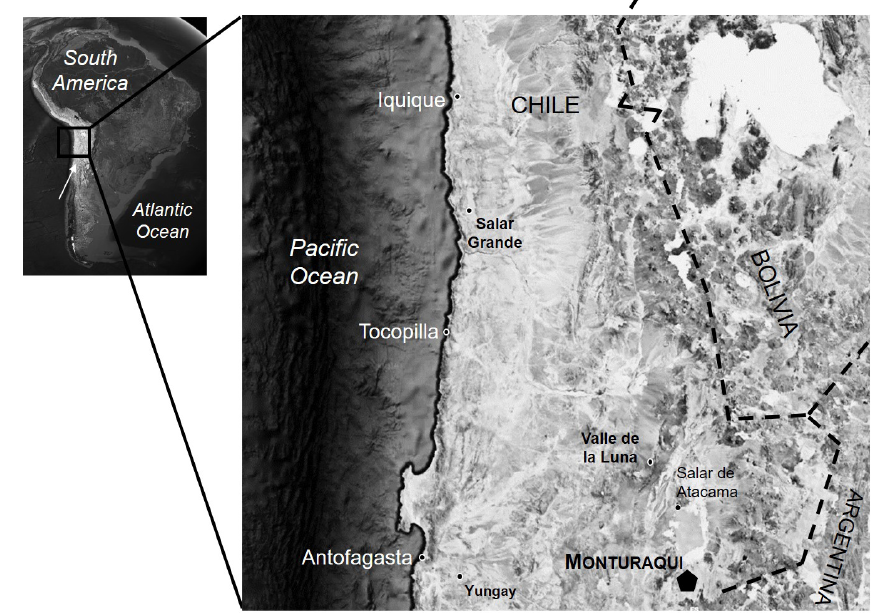
Figure 1. Sampling location in the Atacama Desert. Monturaqui area: MTQ (black diamond). (© Google Earth, image providers: Land-